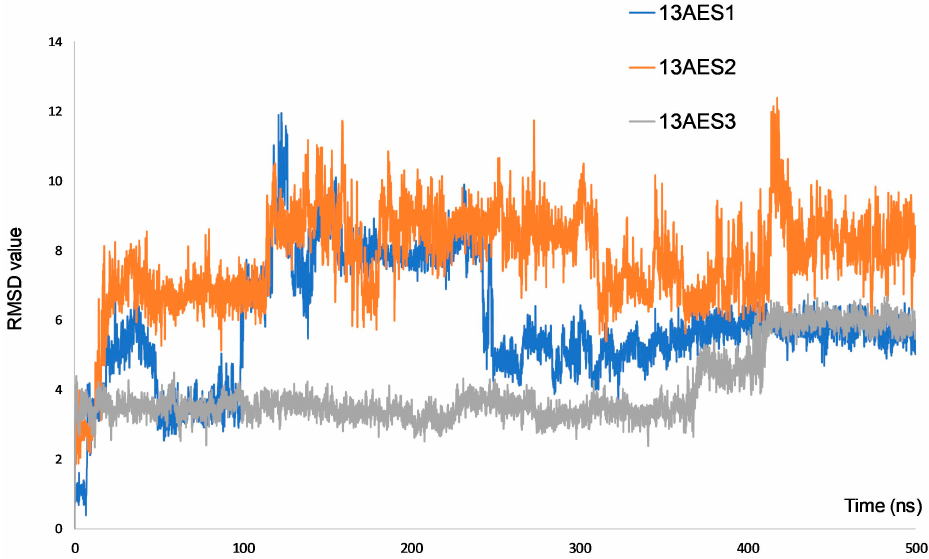
Figure 6. RMSD curves of the three 13AES ligands examined.